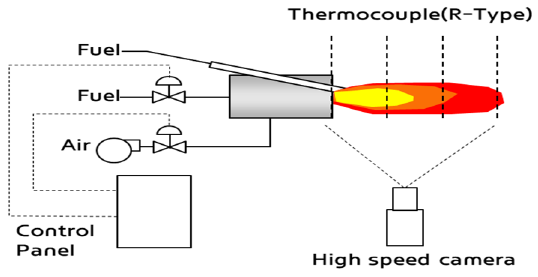
Figure 1. Schematic of the experimental setup.